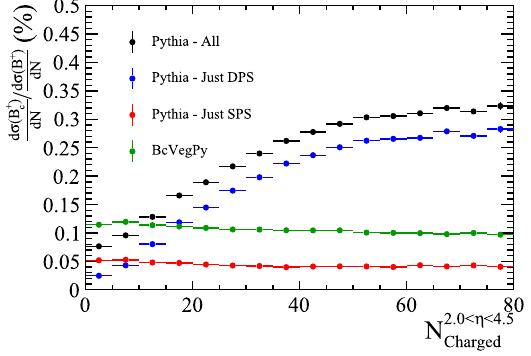
pseudo-rapidity region 2 . 0 < η < 4 . 5, as generated with BcVegPy and Pythia . Uncertainties are from simulation statistics only